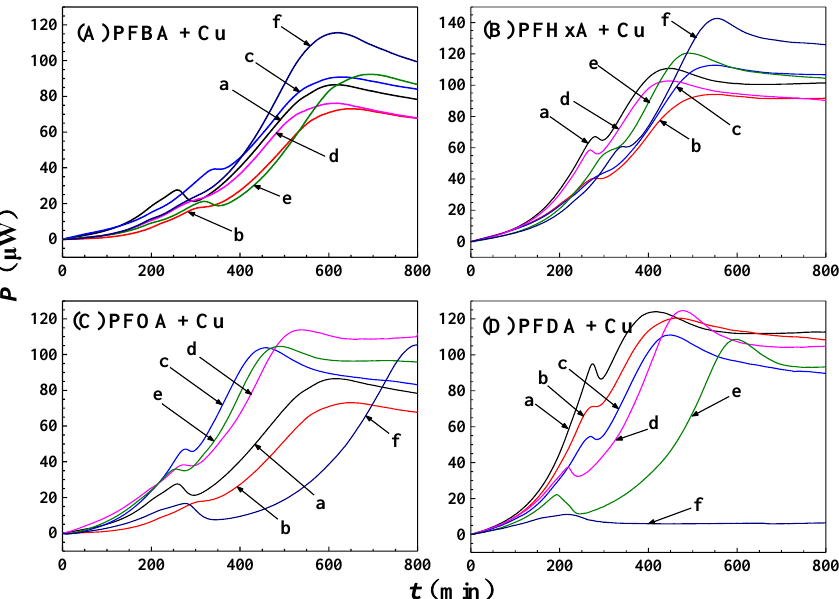
Figure 4. The power-time curves of GQ-9 growth at different concentrations of PFCAs with the addition of 5 mg/L Cu 2+ in LB medium. ( a ) 0 mg/L; ( b ) 20 mg/L; ( c ) 40 mg/L; ( d ) 80 mg/L; and ( e ) 160 mg/L.